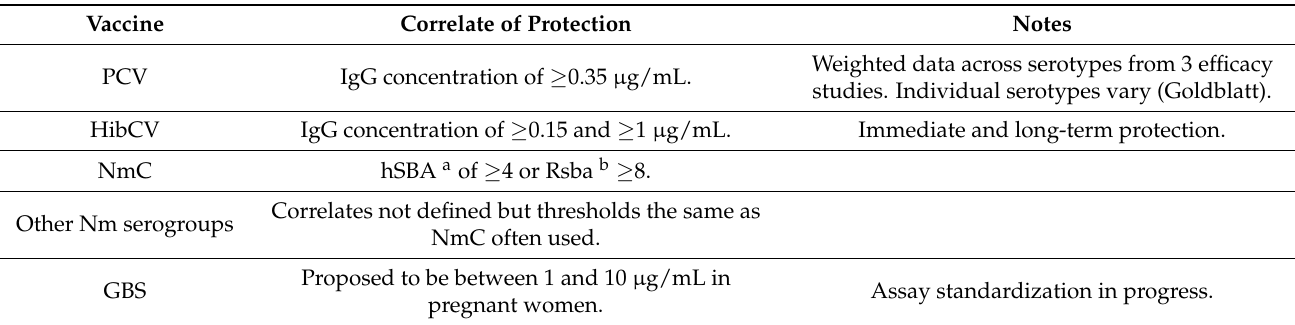
Table 4. Immunological correlates of protection for Hib, meningococcal, pneumococcal, and group B streptococcus (GBS) vaccines [37–39,63,64]. Vaccine Correlate of Protection Notes Weighted data across serotypes from 3 efficacy IgG concentration of ≥ 0.35 µ g/mL. studies. Individual serotypes vary (Goldblatt). Immediate and long-term